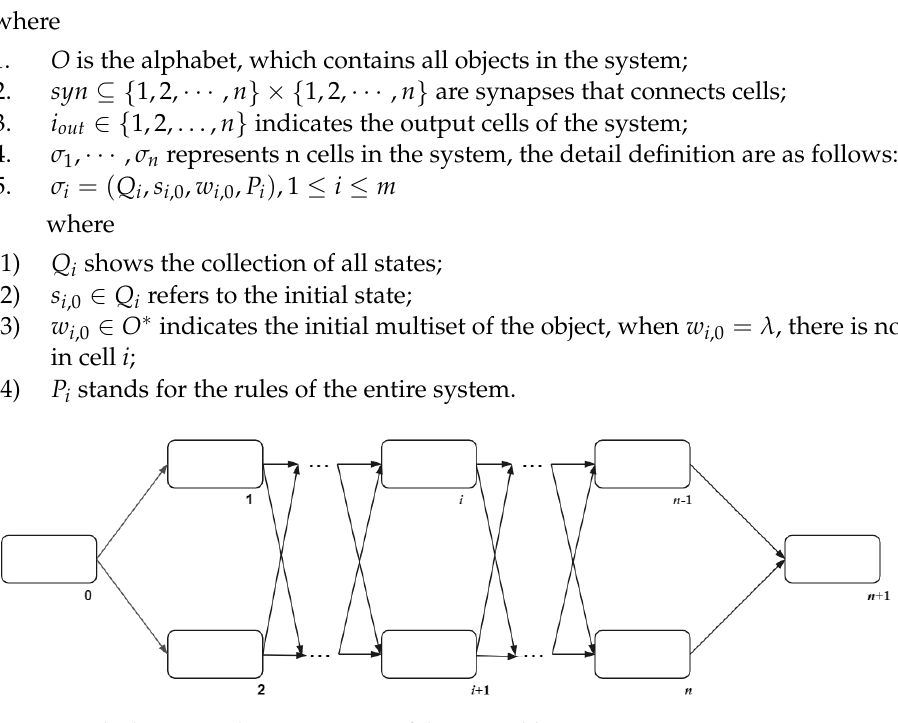
Figure 4. The basic structure of the coupled P system. The formal definition of the coupled P system is 0 ( , , ,